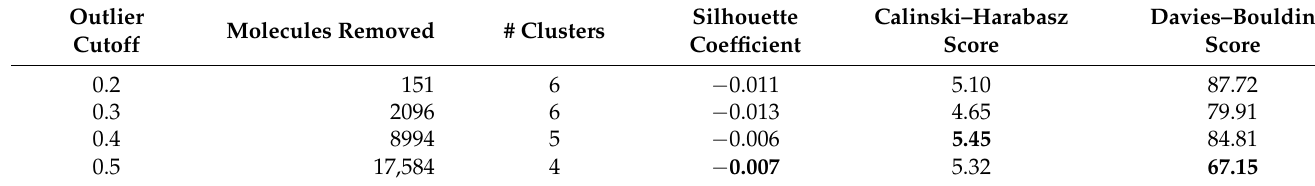
Table 1. Hierarchical clustering (with Ward linkage = 3) to identify the best outlier cutoff. Increas- ing the outlier cutoff, and thus removing more molecules, leads to better quality clustering according to the three selected metrics. Comparison of outlier cutoffs based on the number of molecules removed and the clustering metrics. The best value for each metric is highlighted in bold. For readability, clustering quality results were rounded to either two or three decimal